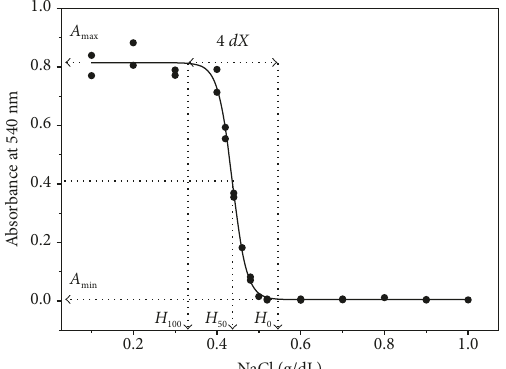
Figure 1: Typical curve of osmotic stability of erythrocytes. The lower plateau defines the A min variable, which represents the amount of basal hemolysis present in the blood sample of each study volunteer. The decrease in the tonicity of the medium is associated with increased lysis of erythrocytes and release of hemoglobin in the solution, resulting in increased absorbance at 540nm with formation of a curve of sigmoidal nature whose upper plateau defines the A max variable, which represents the occurrence of 100% hemolysis. The curve passes through an intermediate point defining the H 50 variable, which represents the concentration of NaCl required to promote 50% hemolysis. The saline concentration at the starting point of the curve defines the H 0 variable, which is the saline concentration required to initiate in vitro hemolysis and which can be calculated by the formula H 0 � H 50 +4 dX /2. The saline concentration at the point where the in vitro lysis reaches its maximum plateau defines the H 100 variable, which represents the saline concentration necessary to promote the total lysis of the red blood cells, being calculated by the formula H 100 � H 50 − 4 dX /2. The dX variable represents a quarter of the variation in saline concentration required to promote 100% hemolysis.